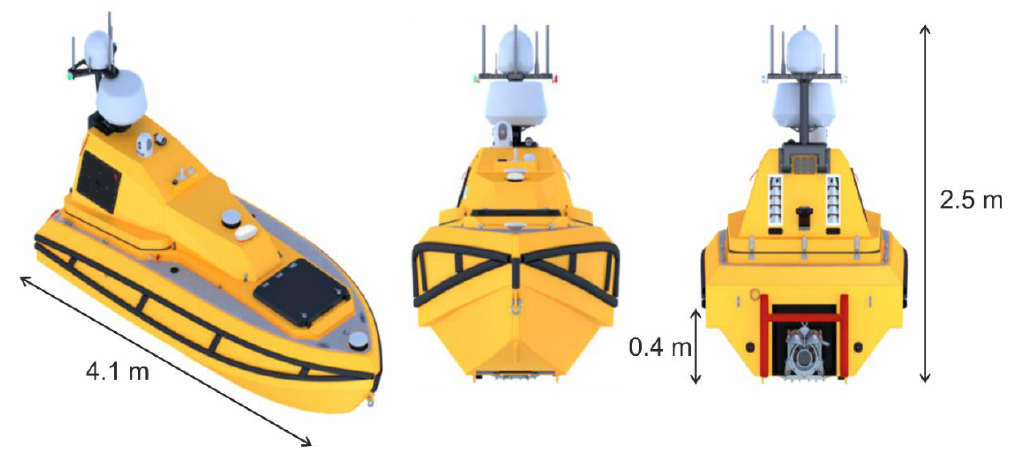
Figure 1. Isometric, front and back view of the CW4 (adapted from L3 Harris C Worker 4 Autonomous Surface Vehicle Use Manual [34]).